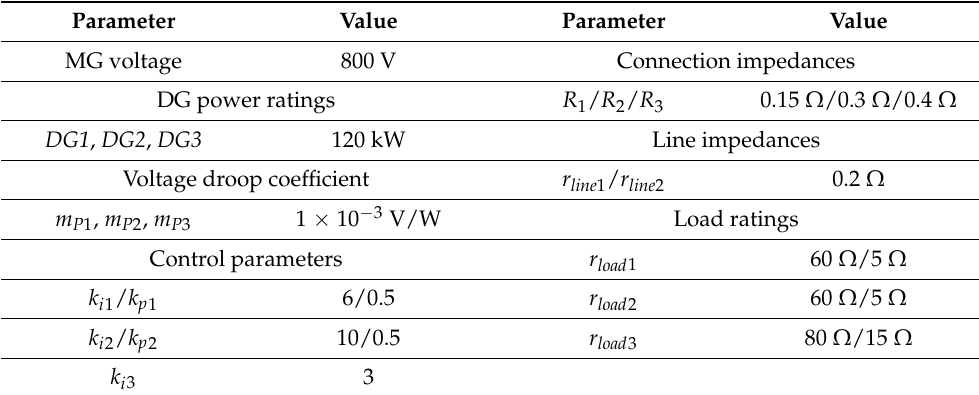
Table 1. Network and control parameters.